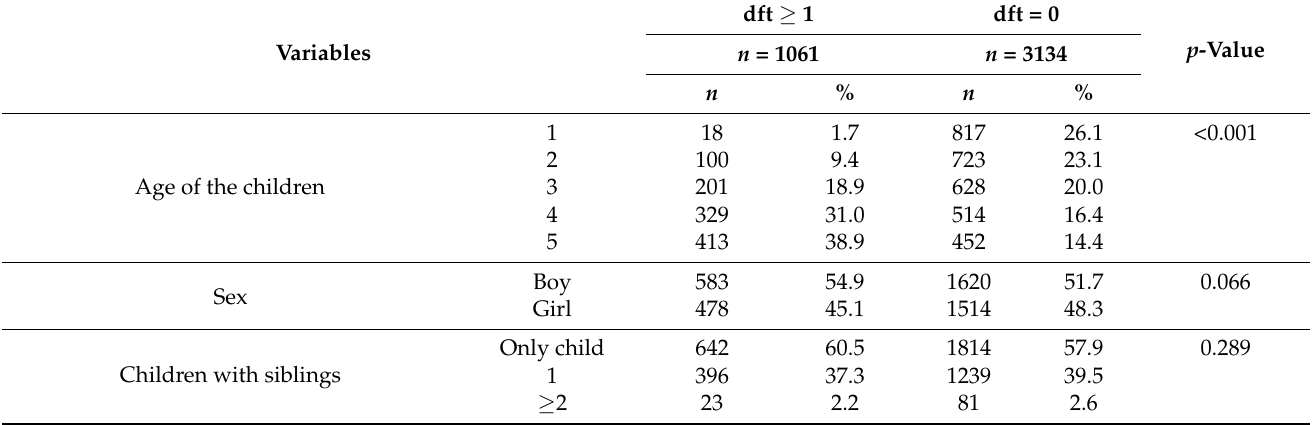
Table 1. Characteristics of participants based on early childhood